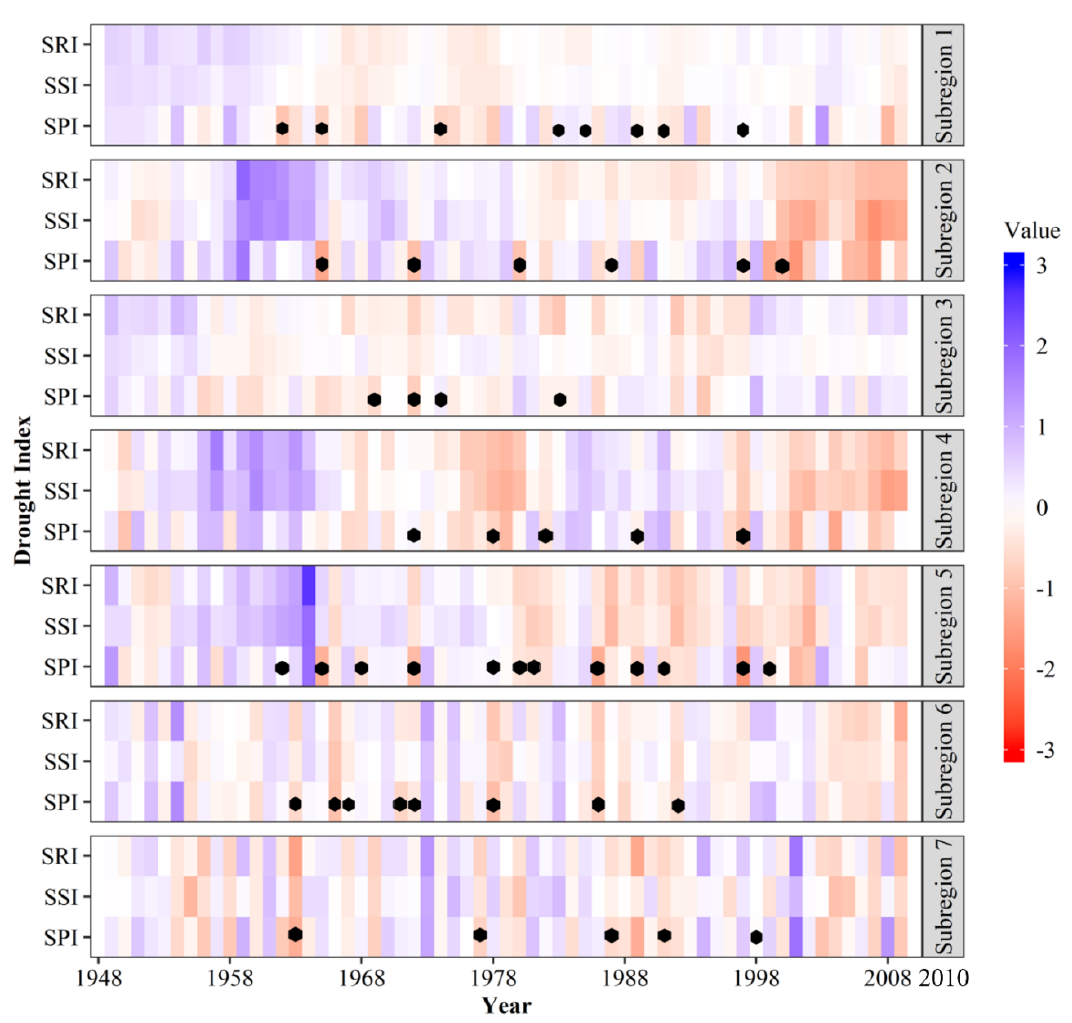
Figure 7. The temporal variations of 12-month SPI, SSI, and SRI over 1948–2010 compared with the historically-recorded severe or extreme drought events (1960–2000) in seven sub-regions of mainland China.